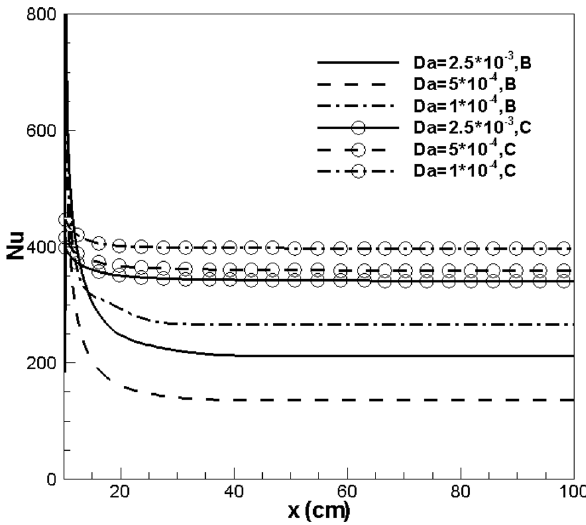
Fig. 8 Variation of Nu with Da for boundary (B) and central (C)